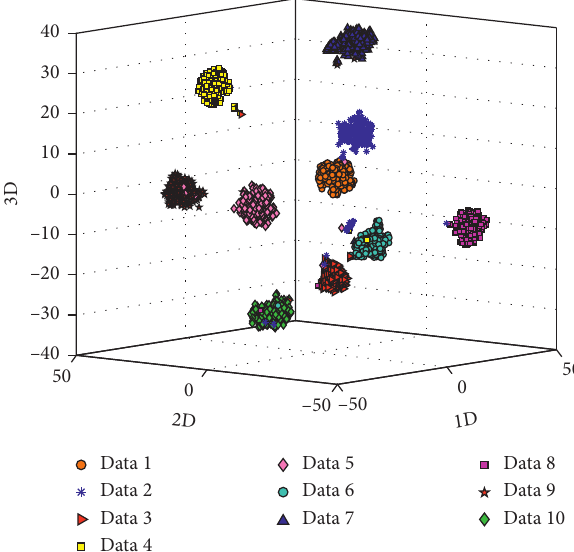
Figure 7: 3D feature scatter diagram of the second hidden